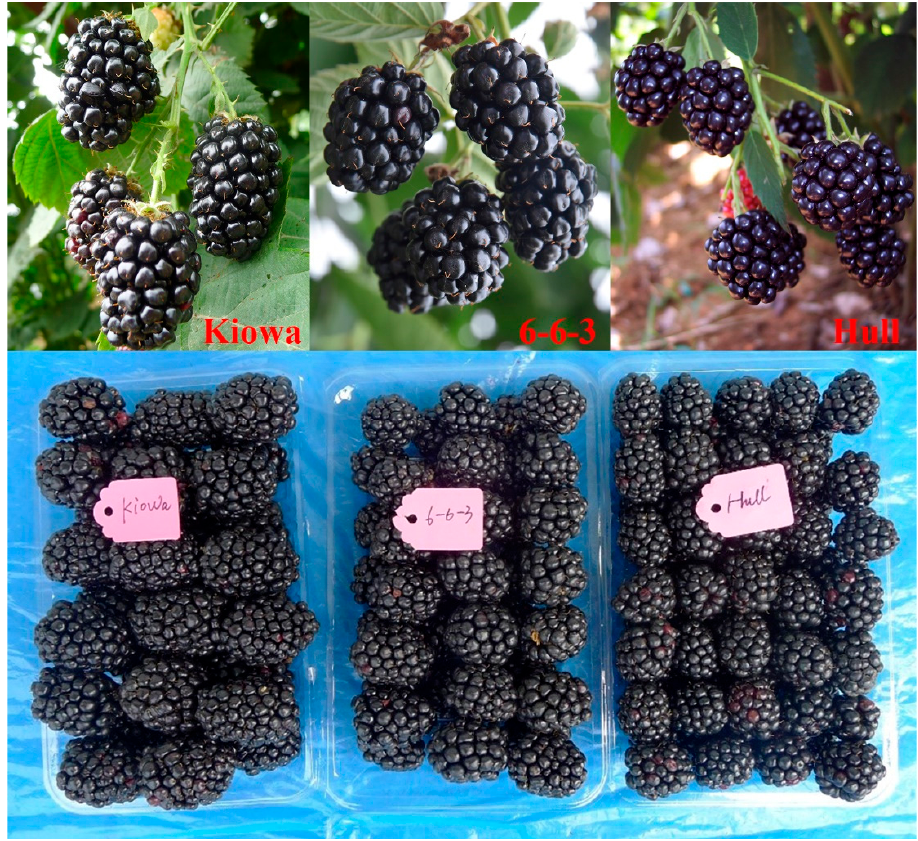
Figure 2. Ripe fruits of ‘Kiowa,’ ‘Ningzhi 4 ′ (6-6-3) and ‘Hull